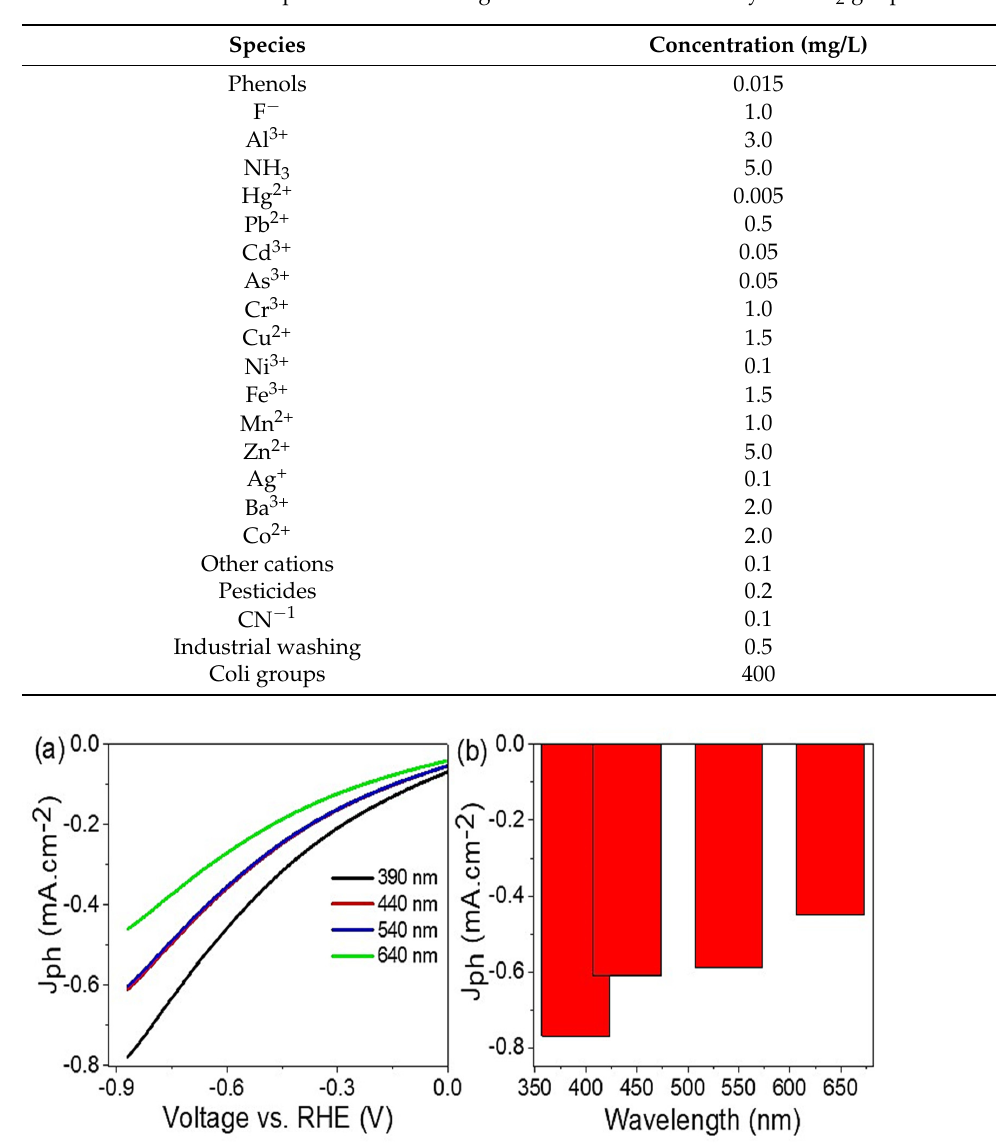
Figure 4. ( a ) The effect of monochromatic wavelengths on the prepared CuFeO 2 /CuO/Cu photoe- trode and ( b ) the produced J ph values at − 0.88